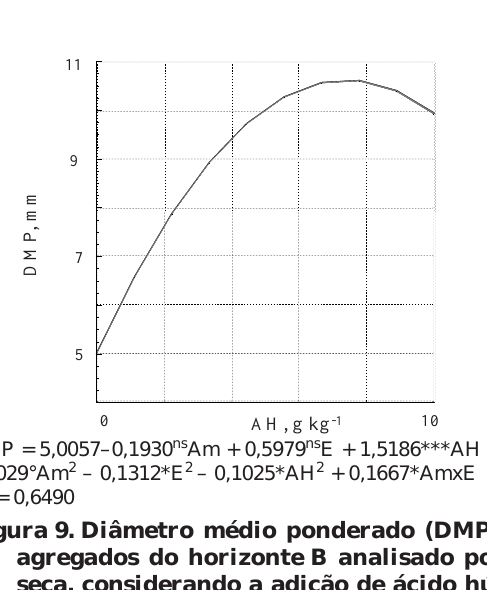
Figura 9. Diâmetro médio ponderado (DMP) dos agregados do horizonte B analisado por via seca, considerando a adição de ácido húmico (AH), para doses de amido (Am) e ácido esteárico (E) iguais a zero.